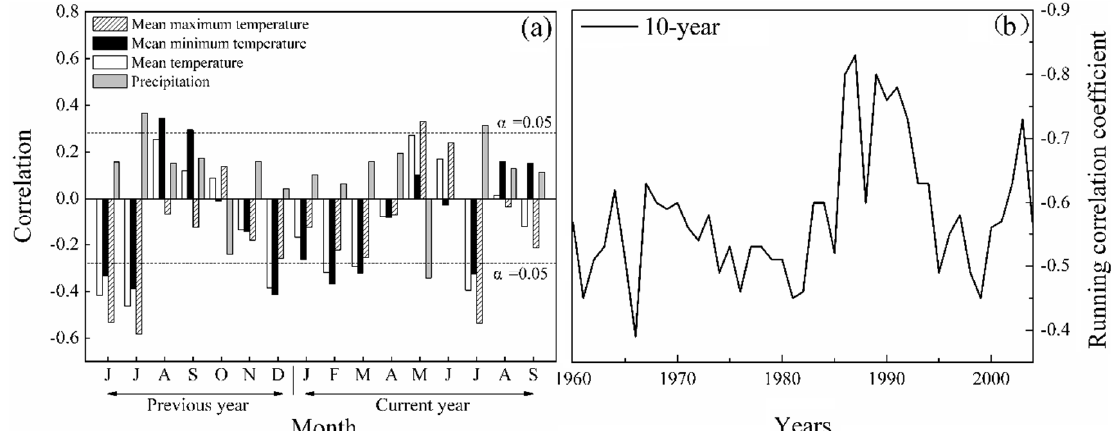
Figure 4. ( a ) Correlations between the standard chronology and monthly climate data, including monthly total precipitation (Prec), mean maximum temperature (Tmax), mean minimum temperature (Tmin), and mean temperature (Tm) from CBM during 1960–2005. The dashed lines indicate the 95% confidence level. ( b ) Running correlation between the ring-width index and mean maximum temperature from June to July of the previous year with a 10-year window.